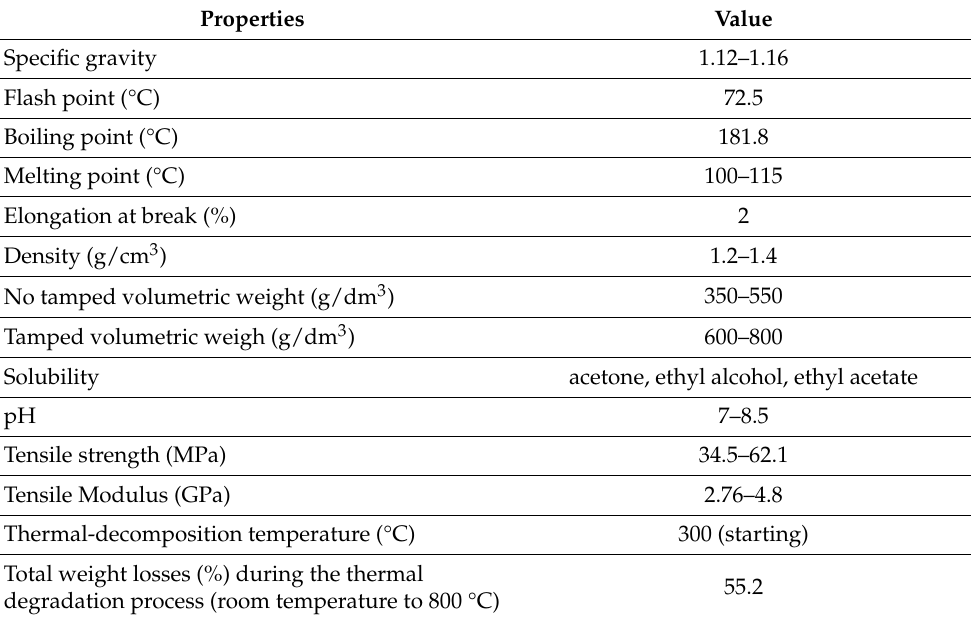
Table 3. Physical and mechanical properties of phenolic resin